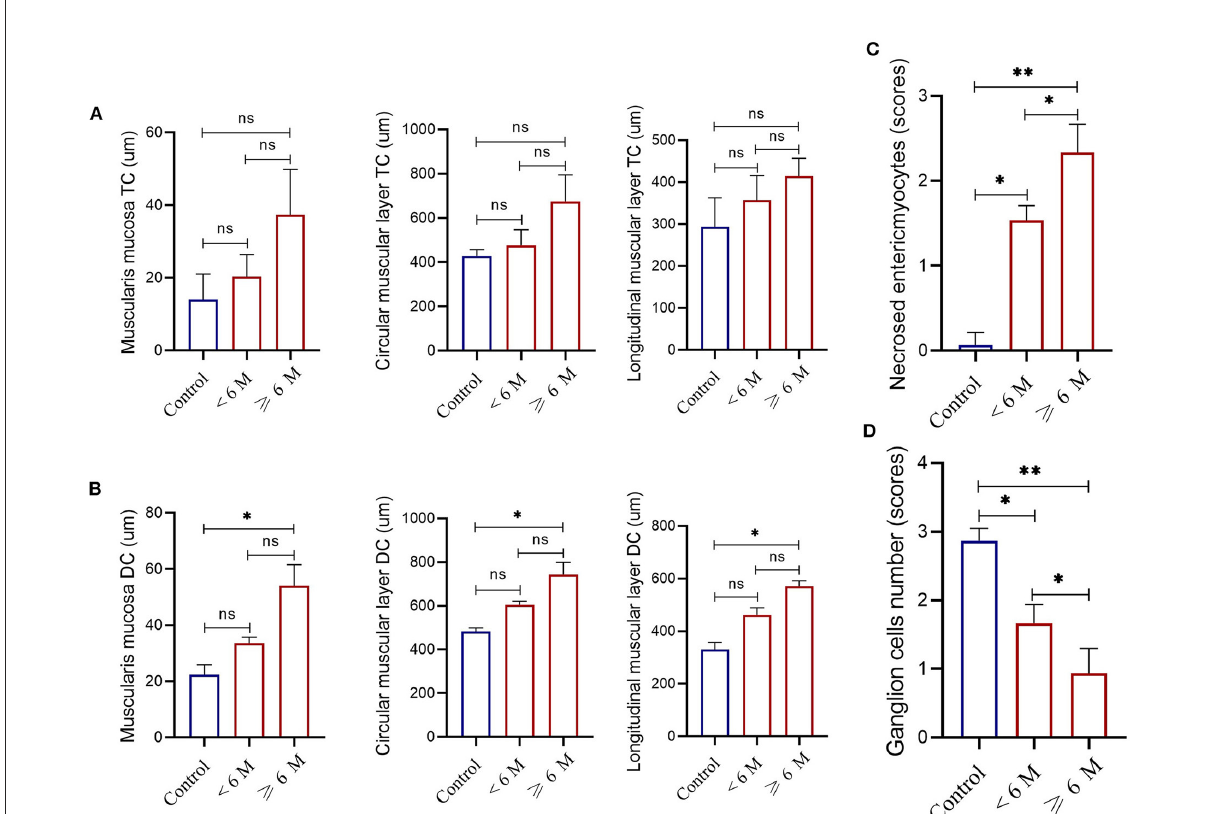
FIGURE9 Measurements of the thickness of the muscularis mucosa, and the inner circular and outer longitudinal smooth muscle layers of the muscularis externa obtained from the transverse colon [TC, (A) ] or descending colon [DC, (B) ] in controls ( n = 5) and case cats with idiopathic megacolon and grouped based on the duration of constipation/obstipation, < 6 months ( n = 3) and ≥ 6 months ( n = 5). Necrotized enteric myocytes (C) and ganglion cells (D) mean scores in controls and grouped case cats with idiopathic megacolon. Data are given as mean ± SD. ns, not significant. * p < 0.05; ** p < 0.005.